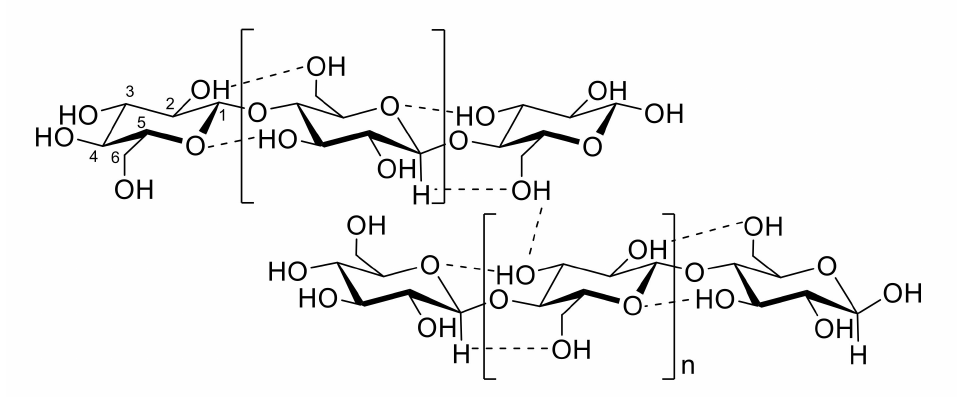
Figure 1. Intra-chain and inter-chain hydrogen bonding in cellulose. Cellulose fiber has a defined hierarchical order in its organization. Native cellulose fiber consists of several microfibrils (5–10 nm in diameter each, depending on plant tissue and species) bundled together. In turn, microfibrils are made of stacked semi-crystalline elementary fibrils. Sequentially, elementary fibrils, with dimensions of 3.5 × 5.3 nm each, are assembled from glucan chains (generally, 36) [10]. Bacterial cellulose (BC) is obtained by a build-up of